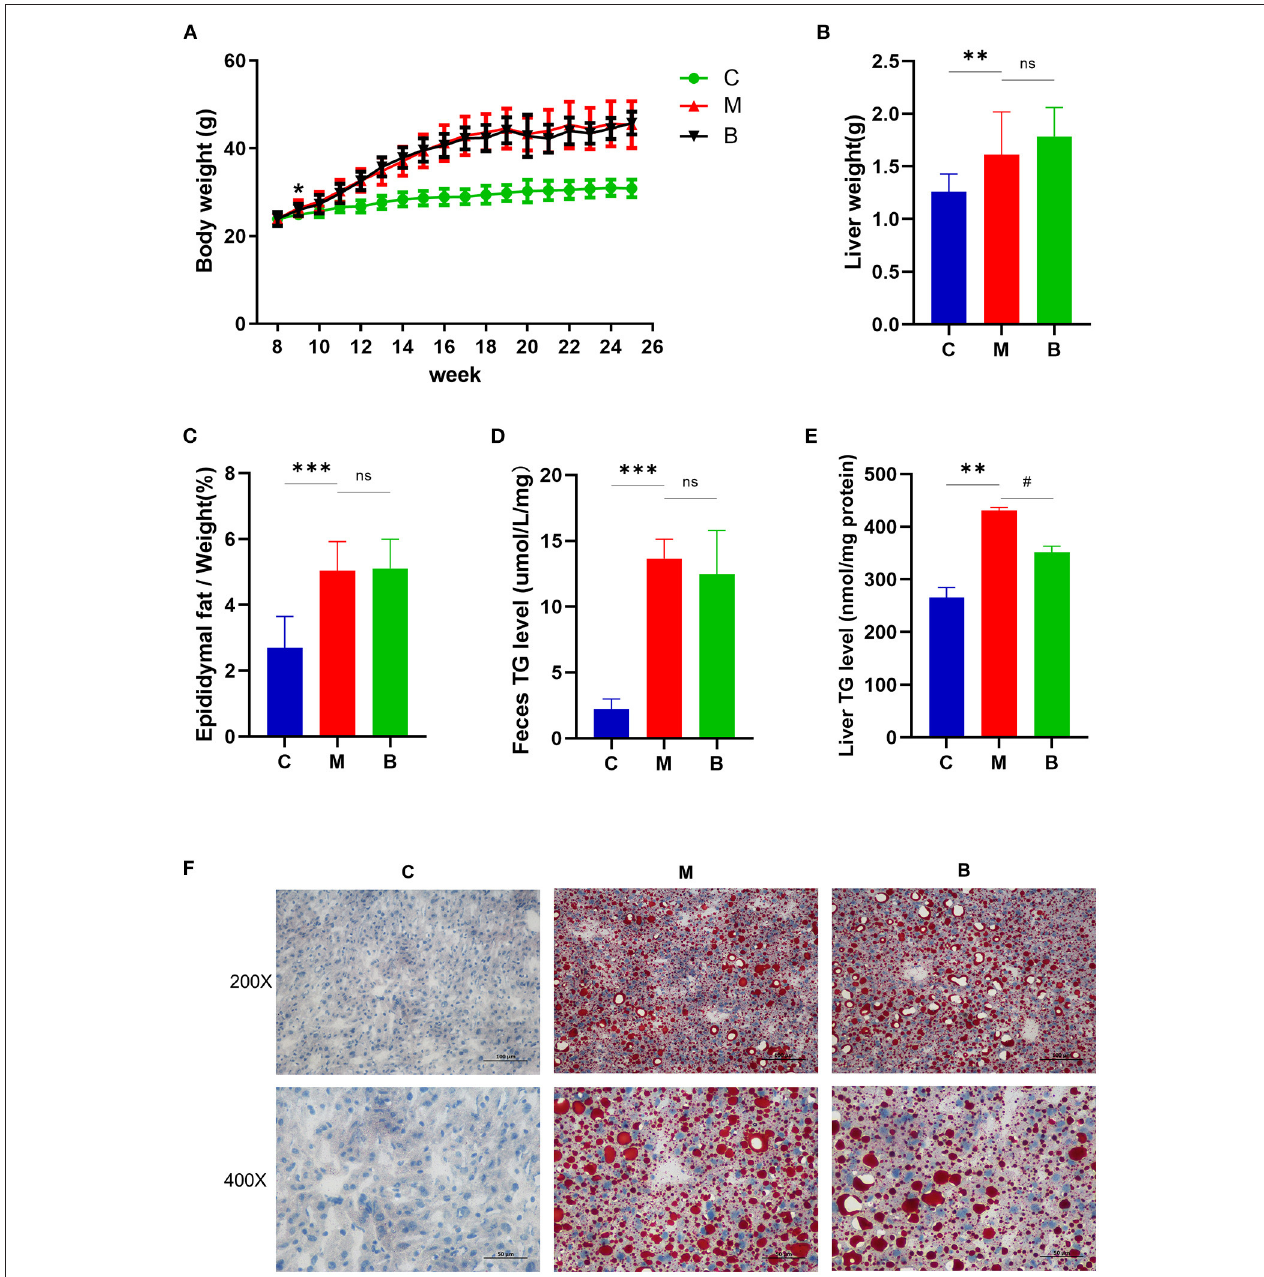
FIGURE 2 | Body weight change and liver lipid levels of C, M, and B group mice. (A) The average body weight of mice in three groups at different times. (B) Liver weight. (C) The epididymal fat/weight (%). (D) Feces TG levels. (E) Liver TG levels. (F) Oil Red O staining (200 × and 400 × magnification) of the liver. * p or # p < 0.05; ** p < 0.01; *** p < 0.001.